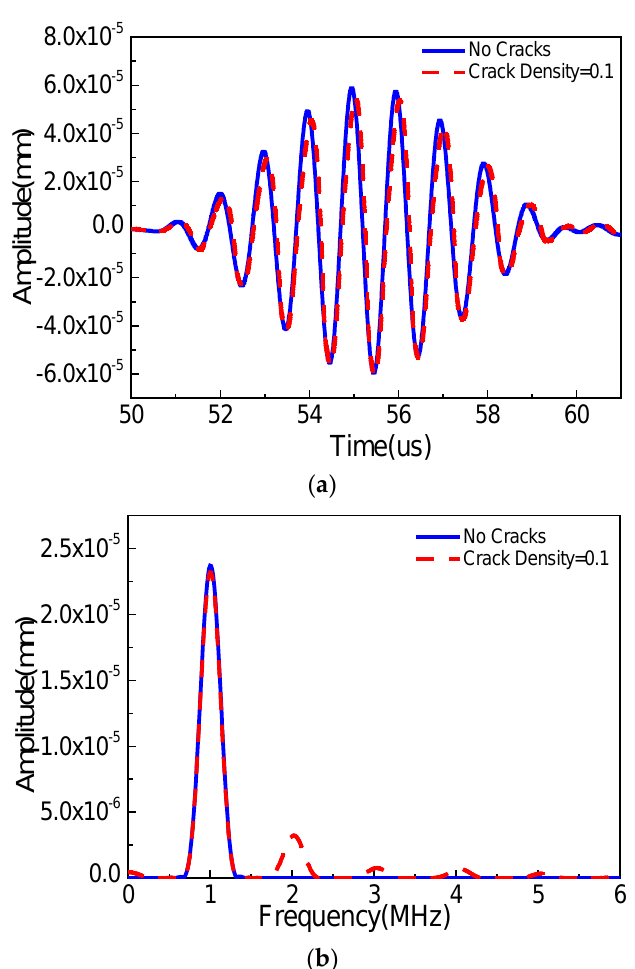
Figure 6. Wave signals in the y direction ( a ) time domain; ( b ) frequency domain ( c = 0.1, f = 1000 kHz, µ = 0.1, % = 60%).